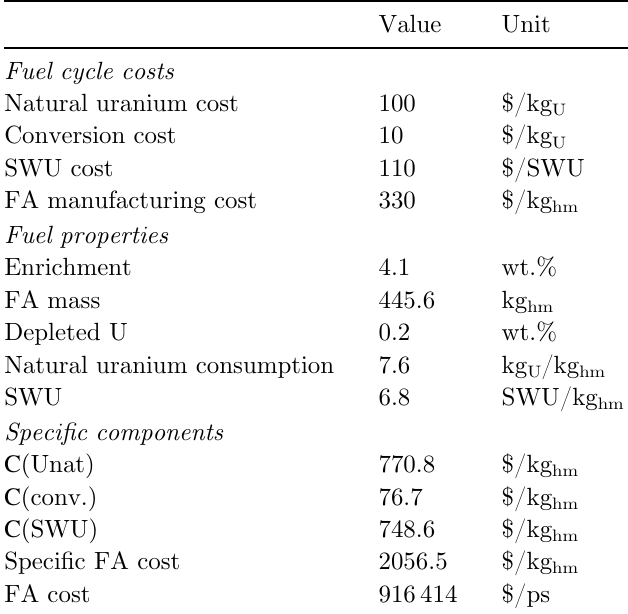
Table 2. FA cost calculation parameters for UOX fuel.